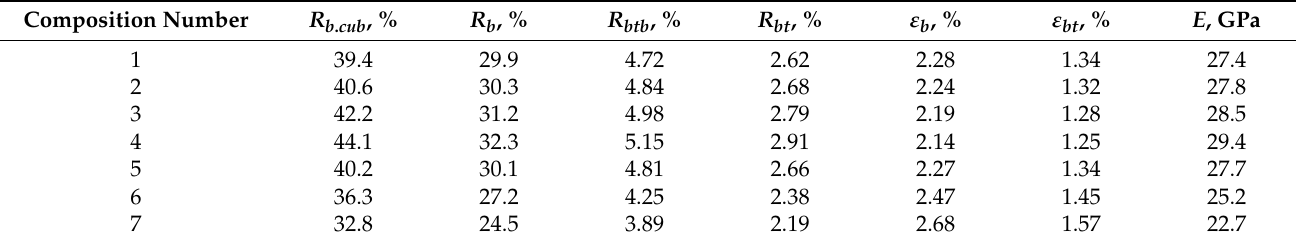
Table 5. Strength and deformation characteristics.